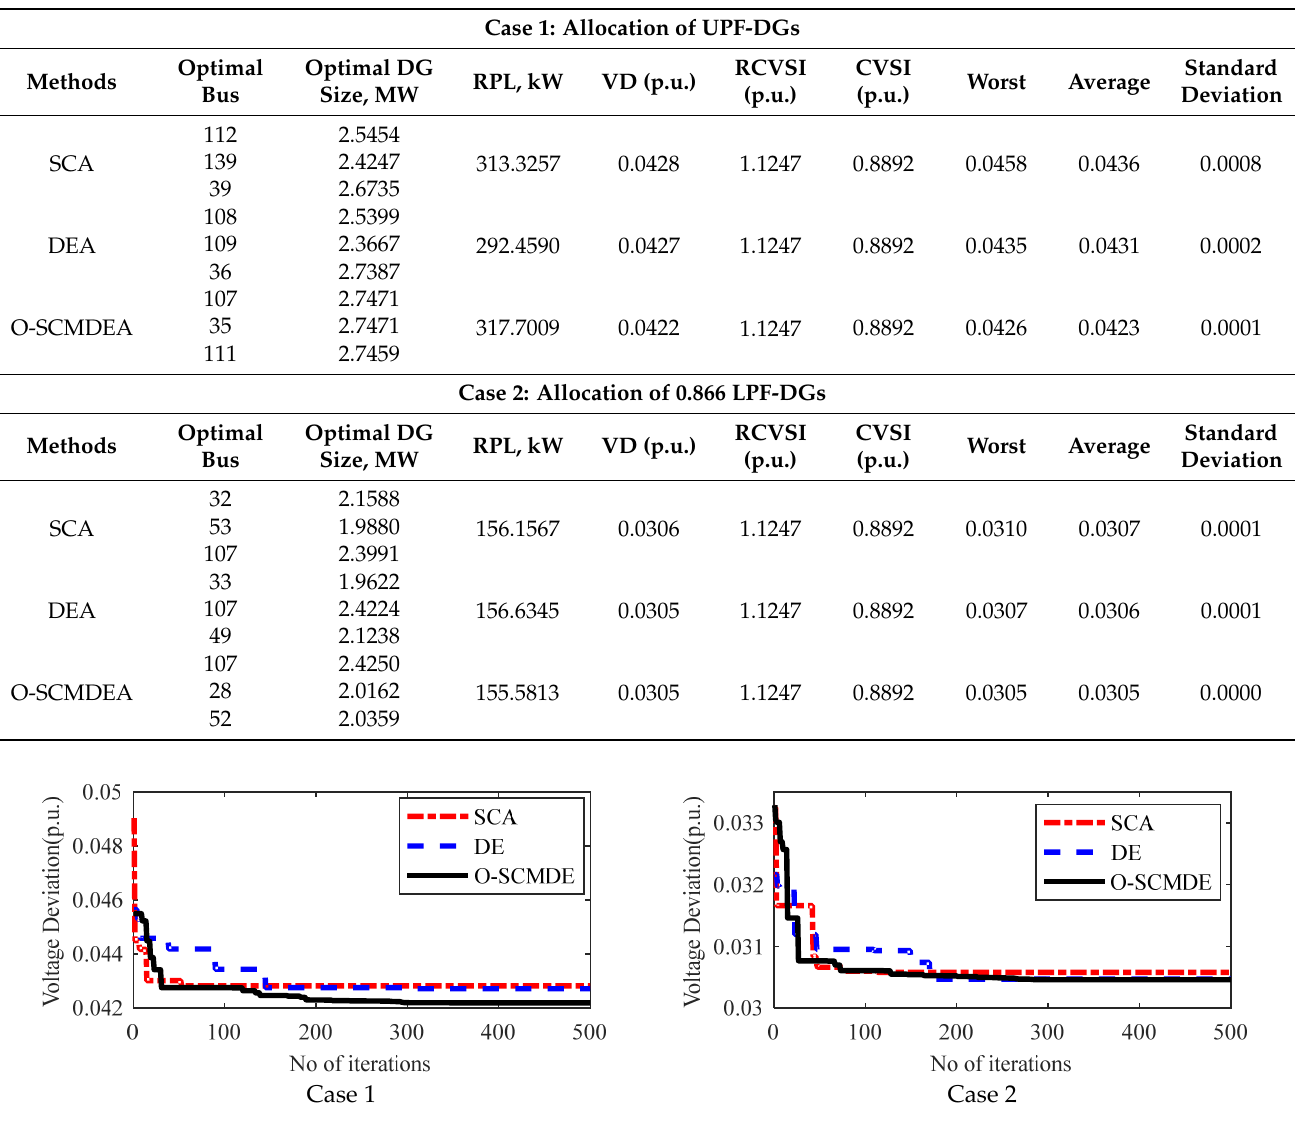
Figure 15. Comparison of the convergence characteristics of the SCA, DEA and O-SCMDEA for both cases of scenario II of the 136 bus system.